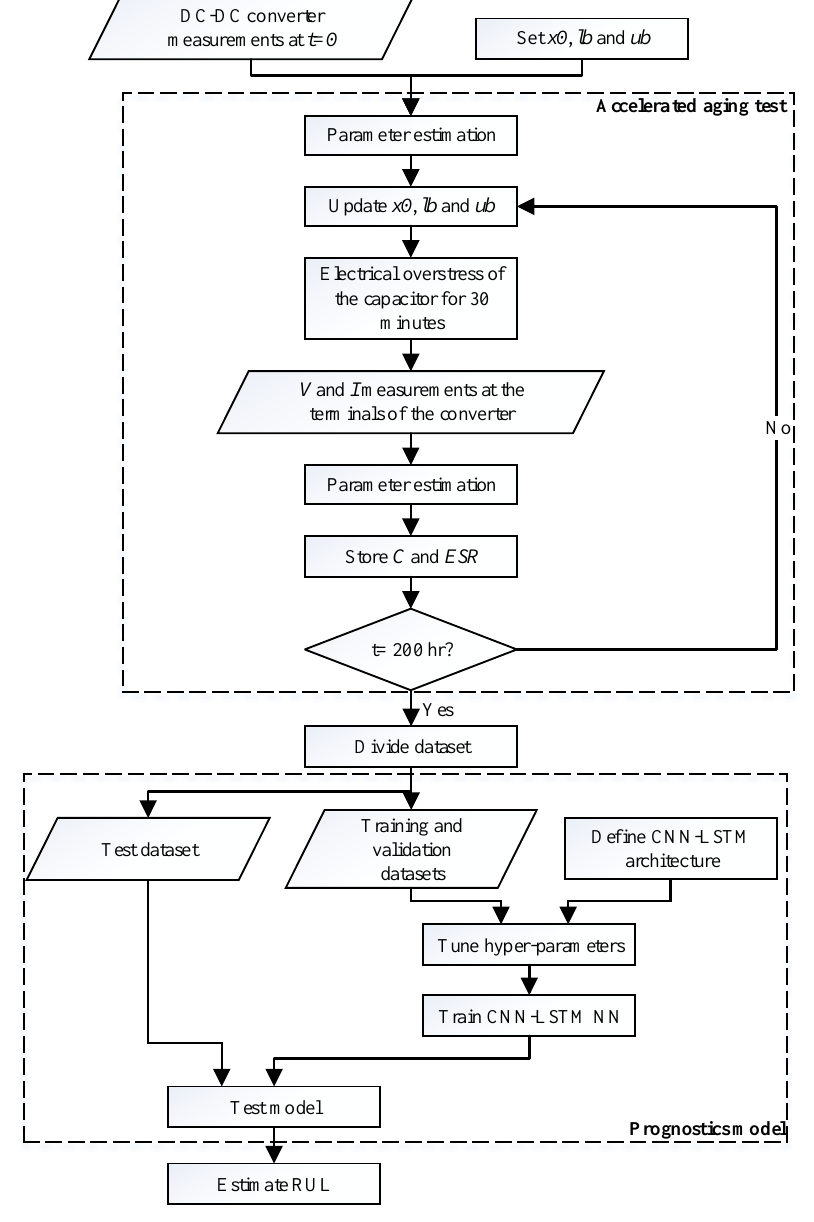
Figure 7. Proposed